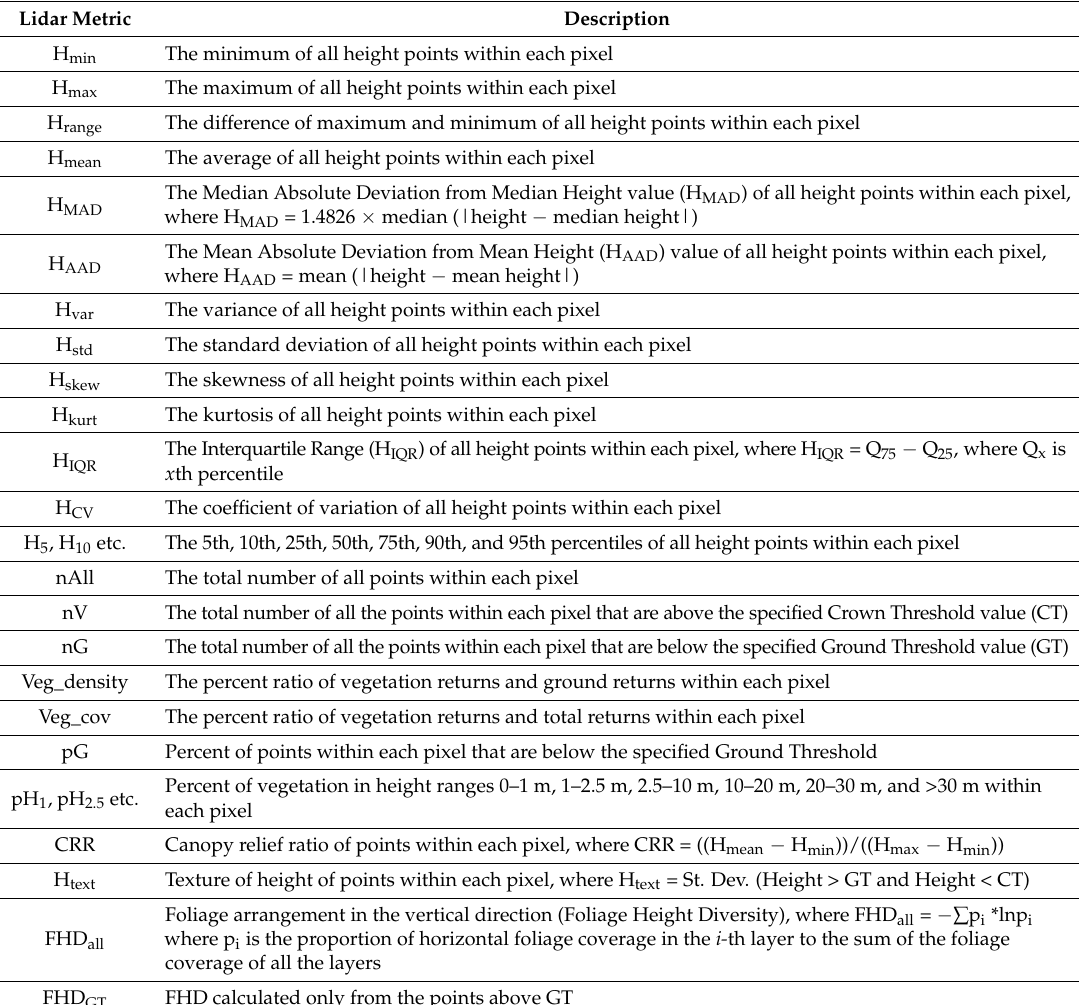
Table 2. Lidar metrics ( n = 35) and their